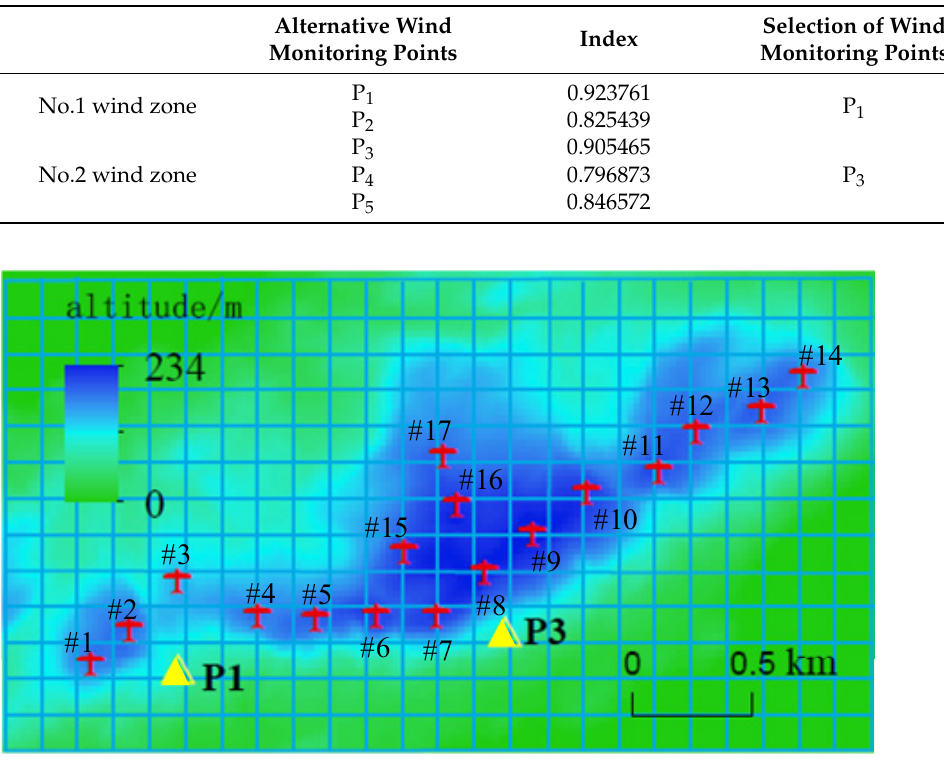
Table 3. Screening results of alternative wind monitoring points.